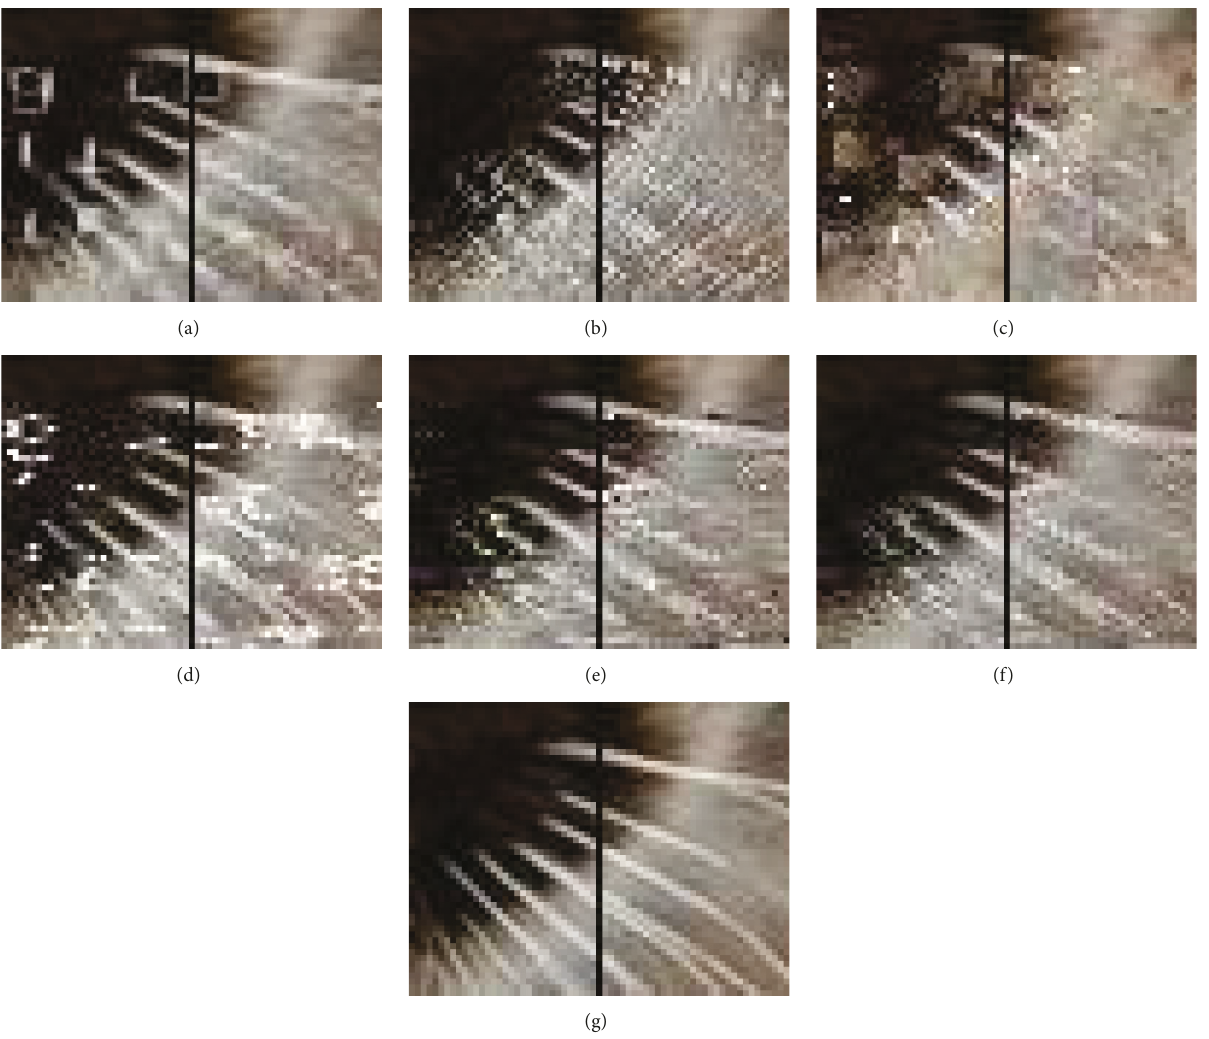
Figure 12: The texture patches display of repaired raccoon images by different inpainting methods. (a) By BSCB; (b) by CT; (c) by EB; (d) by TV; (e) by Thiele; (f) by our method; (g) the original